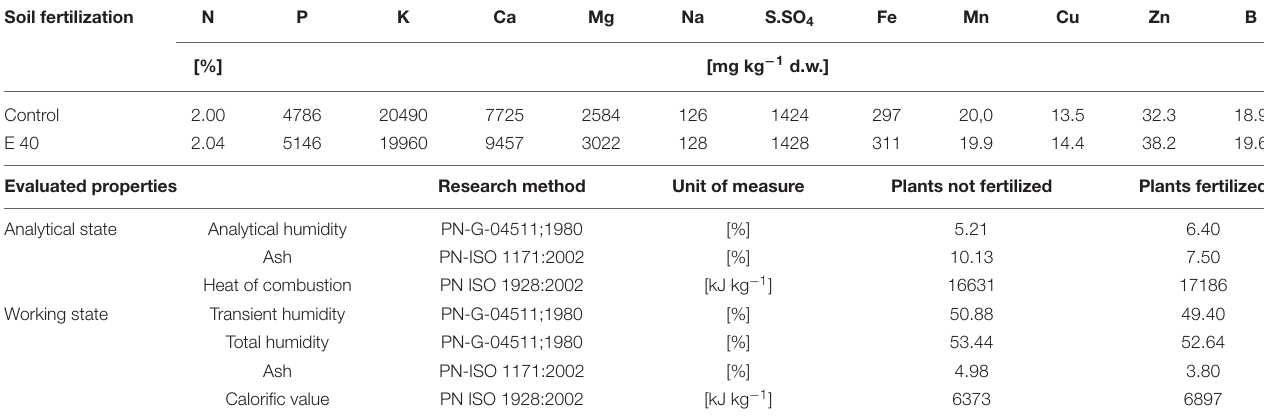
TABLE 8 | Content of macro- and microelements in leaves of sorghum plants grown in field in non-fertilized soil (Control) and that fertilized with the non-centrifuged waste from a biomass biodigestion to methane at a dose of 40 m 3 ha − 1 (E40) and parameters of the energy value of sorghum plants grown in field in un-fertilized soil (Control) and that fertilized with the non-centrifuged waste from a biomass biodigestion to methane at a dose of 30 m 3 ha − 1 , Apol-humus (15 L ha − 1 ) and additionally foliar spraying with Stymjod 1.5% (5 L ha − 1 ). Soil fertilization